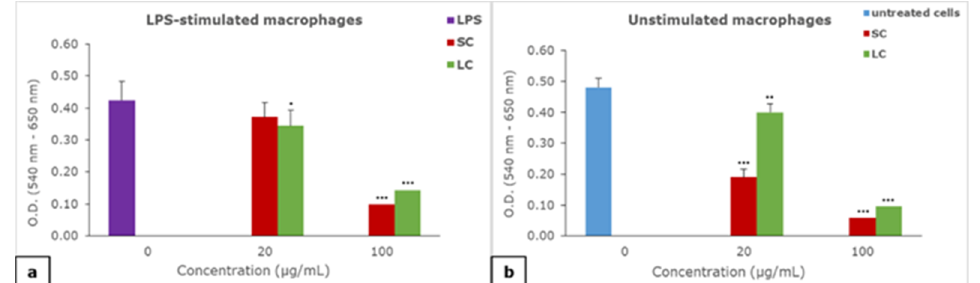
Figure 4. The effect of suspension of material particles on the metabolic activity of macrophages: ( a ) effect of materials on LPS-stimulated macrophages, ( b ) effect of materials on unstimulated macrophages; results are presented as mean ± SD (*) p < 0.05, (**) p < 0.01, (***) p < 0.001; SC—self-curing; LC—light-curing material.